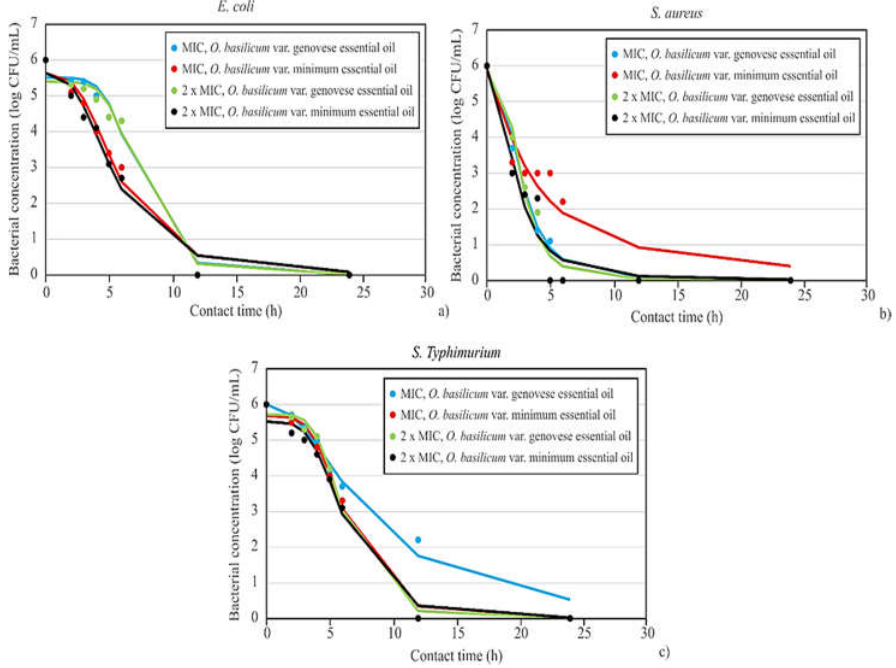
Figure 2. Kinetics during contact time essential oil samples with ( a ) E. coli ; ( b ) S. aureus ; ( c ) S. Typhimurium . Table 5. Regression coefficients for time-kill kinetics study of O. basilicum